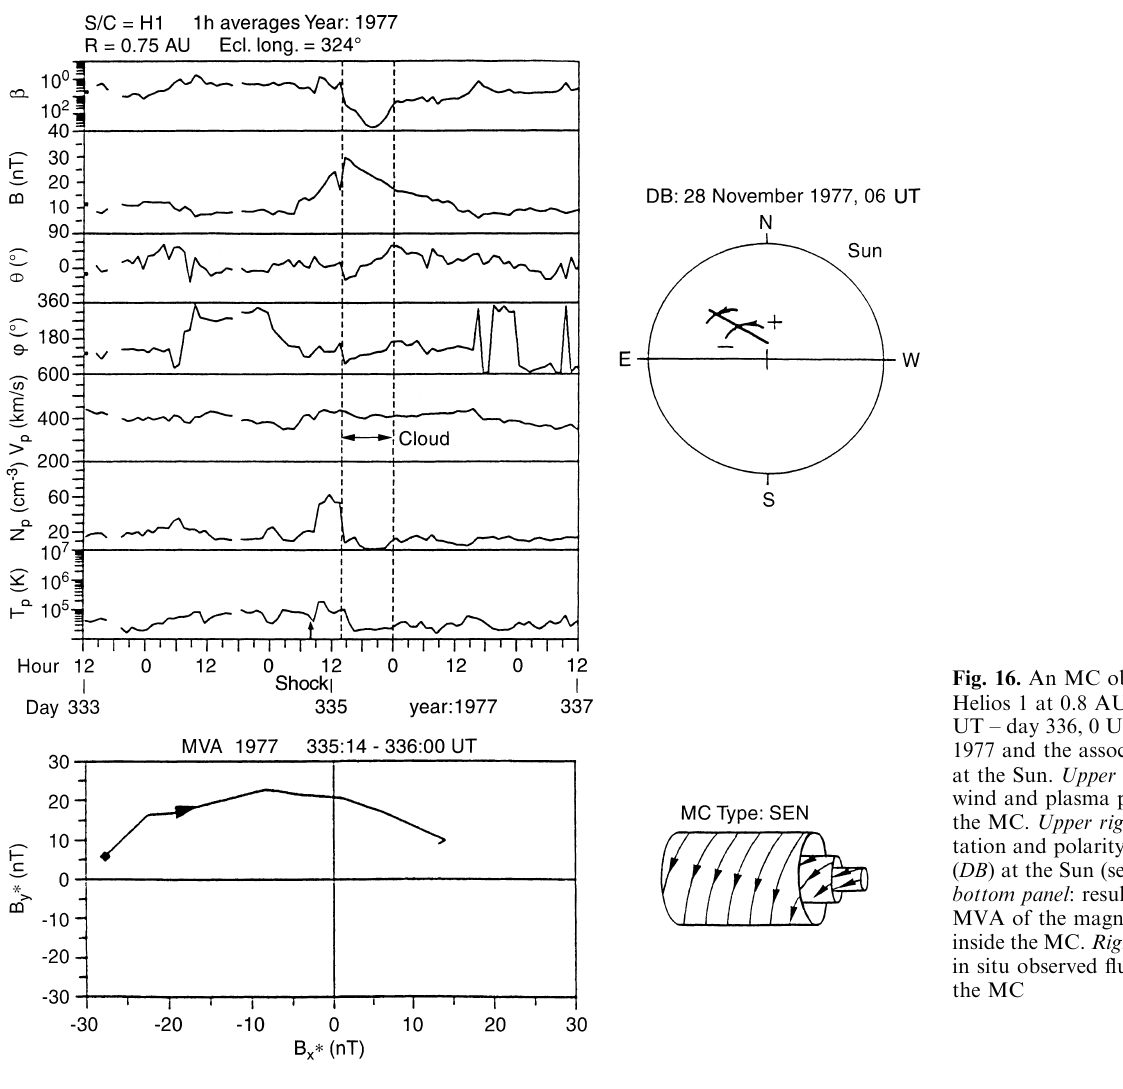
Fig. 16. An MC observed by Helios 1 at 0.8 AU (day 335, 14 UT – day 336, 0 UT) in December 1977 and the associated filament at the Sun. Upper left part : solar wind and plasma parameters for the MC. Upper right part : orien- tation and polarity of the filament ( DB ) at the Sun (see Table 4). Left bottom panel : results from the MVA of the magnetic field data inside the MC. Right bottom panel : in situ observed flux tube type of